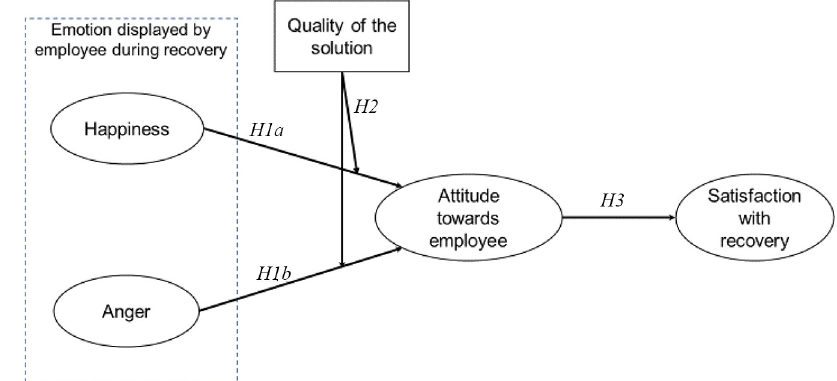
Figure 1. Proposed